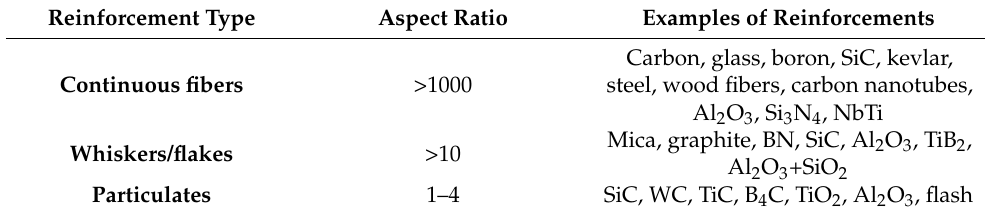
Table 1. Classification of reinforcements